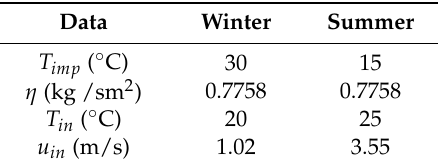
Table 4. Design parameters for Case 1: Le Corbusier hypothesis.